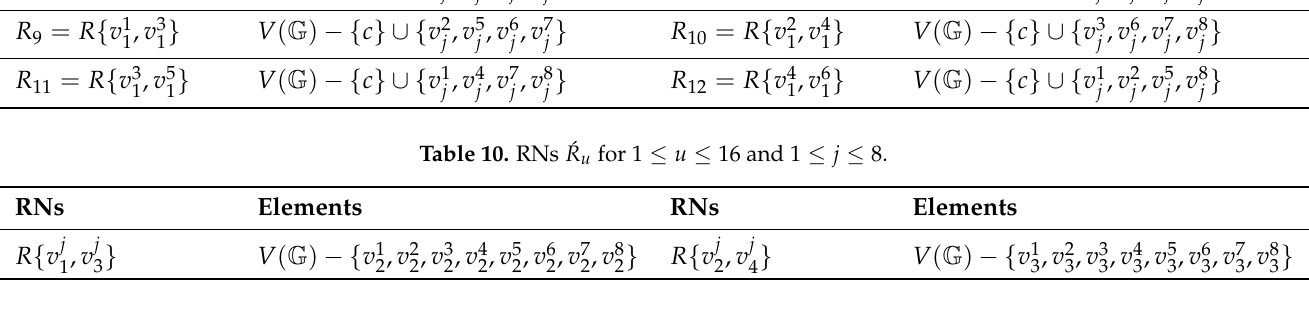
Table 11. RNs ´ R u for 17 ≤ u ≤ 20 and 1 ≤ j ≤ 8.